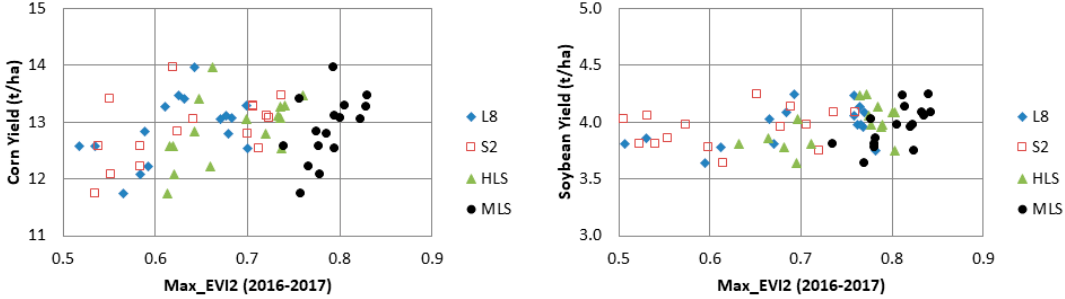
Figure 6. Relationship between yield and maximum EVI2 for Landsat-8 (L8), Sentinel-2 (S2), the Harmonized Landsat-8 and Sentinel-2 (HLS), and MODIS-L8-S2 (MLS) data fusion for corn and soybeans from 2016–2017.